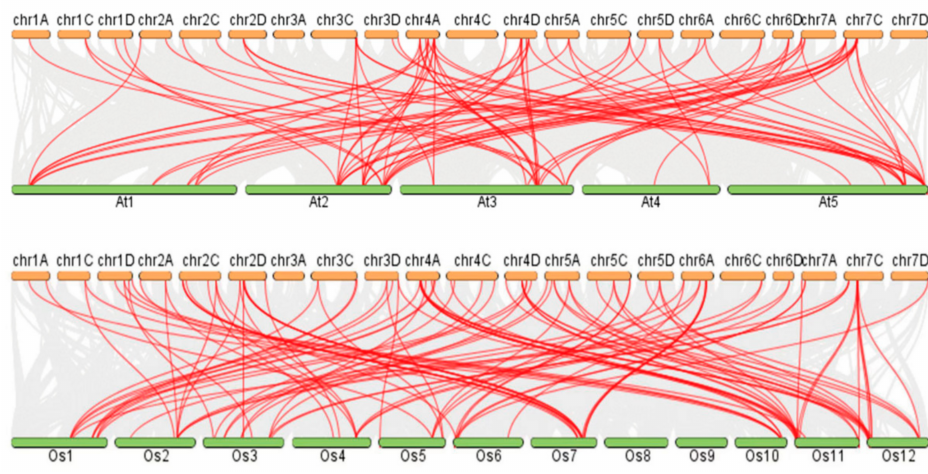
Figure 5. The collinearity map of GRAS